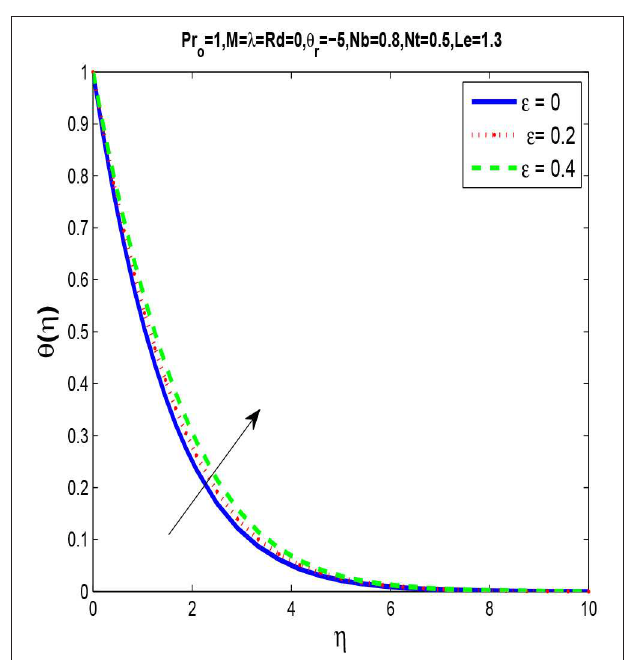
transverse magnetic field as it opposes the phenomenon of transport. The Lorentz force generates resistance to the fluid flow with a rise of M and slows down the